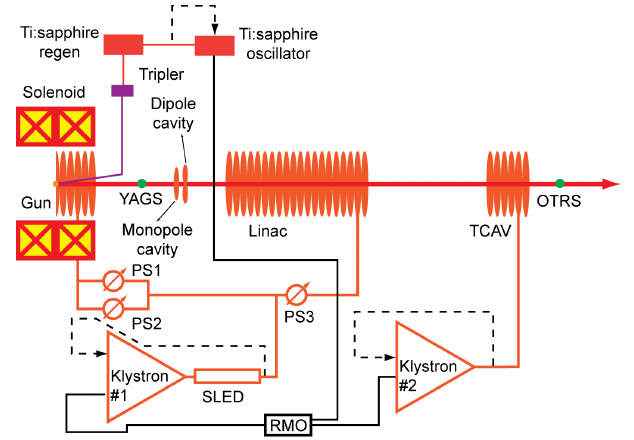
FIG. 3. Schematic of the XTA. PS1, 2, and 3 are rf phase shifters, YAGS is an yttrium aluminum garnet screen, OTRS is an optical transition radiation screen, TCAV is an X-band deflecting cavity (powered by a different RF source) and RMO is the RF master